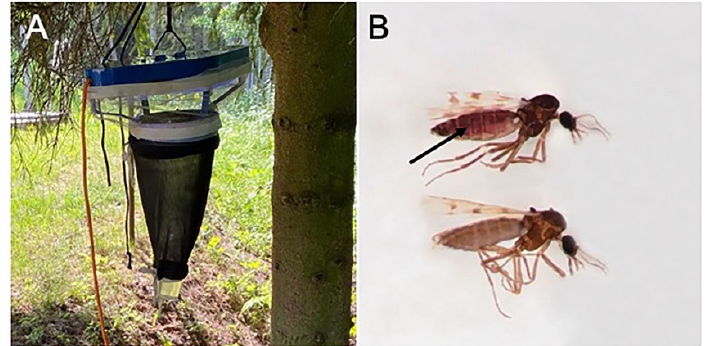
Figure 1. The UV trap in the forest for the catching of biting midges ( A ); parous (arrow) and nulliparous females based on the pigment coloration on the abdomen ( B ).